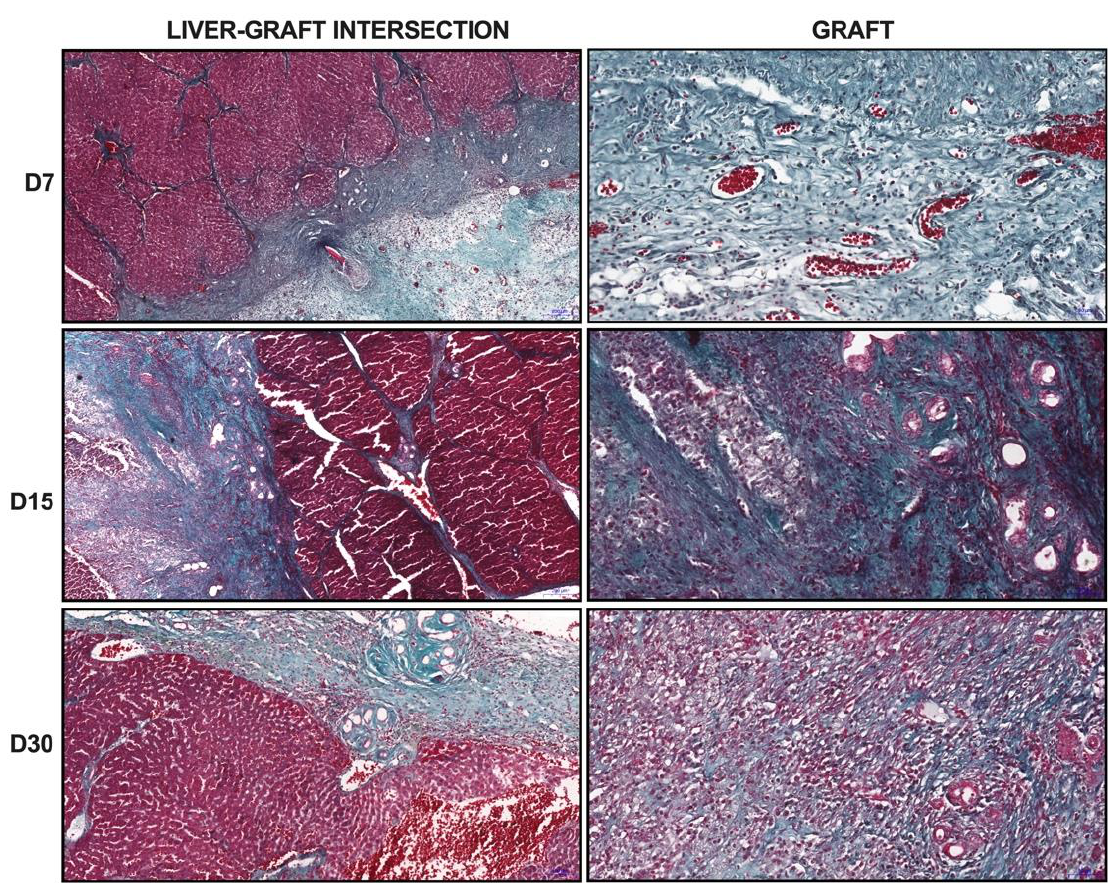
Figure 6. Microscopic view of the transplanted graft tissues . Histological sections stained with Gomori’s trichrome showed transplanted ALS in cirrhotic liver. The images showed an intersection zone that delimited the cirrhotic liver and the transplanted graft. Higher magnification images from ALS at 7, 15, and 30 days post-transplantation showed cell migration, distribution, and graft repopulation. Scale bars: intersection, 200 μm; graft, 50 μm.